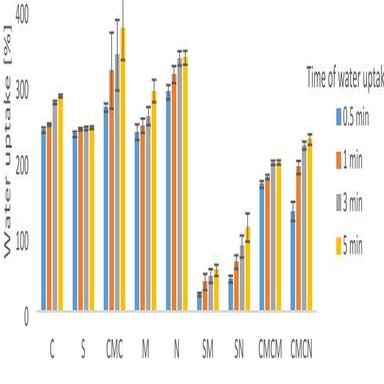
Water uptake of differently treated cellulose.